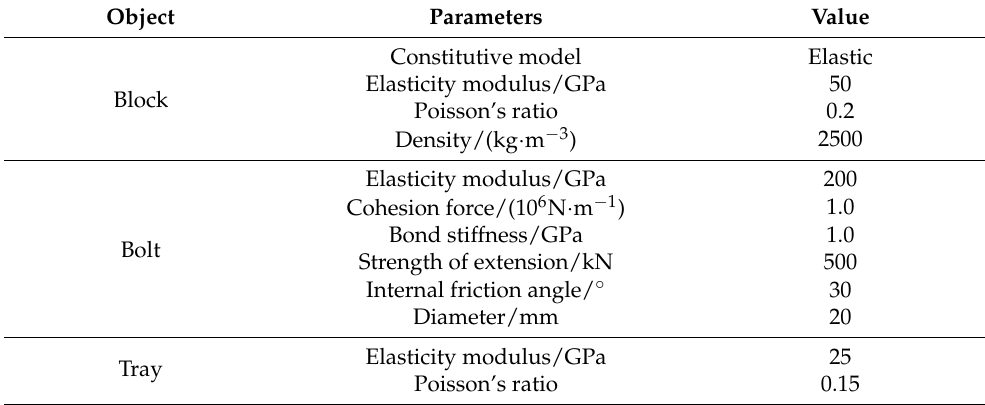
Table 1. The model